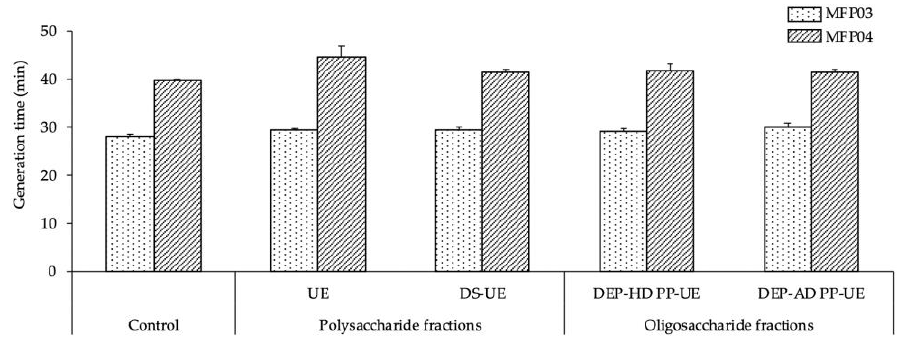
Figure 1. Effects of poly- and oligosaccharide Ulva sp. fractions at 1000 µ g/mL on the growth kinetic of ( a ) S. aureus MFP03 ( n = 3) and ( b ) S. epidermidis MFP04 ( n = 3). Representation of the growth kinetic curve and error standard of each measurement are in log 10 scale.